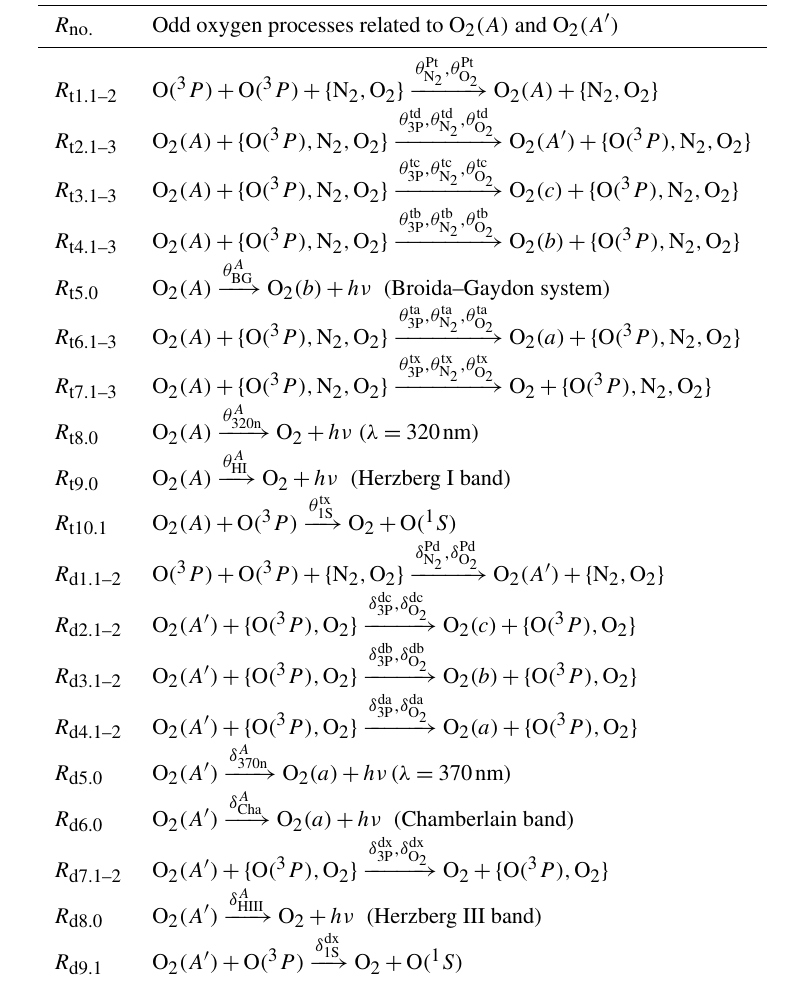
Table 5. Processes of the MAC model, continued by processes shown in Tables 6 and 7. R no